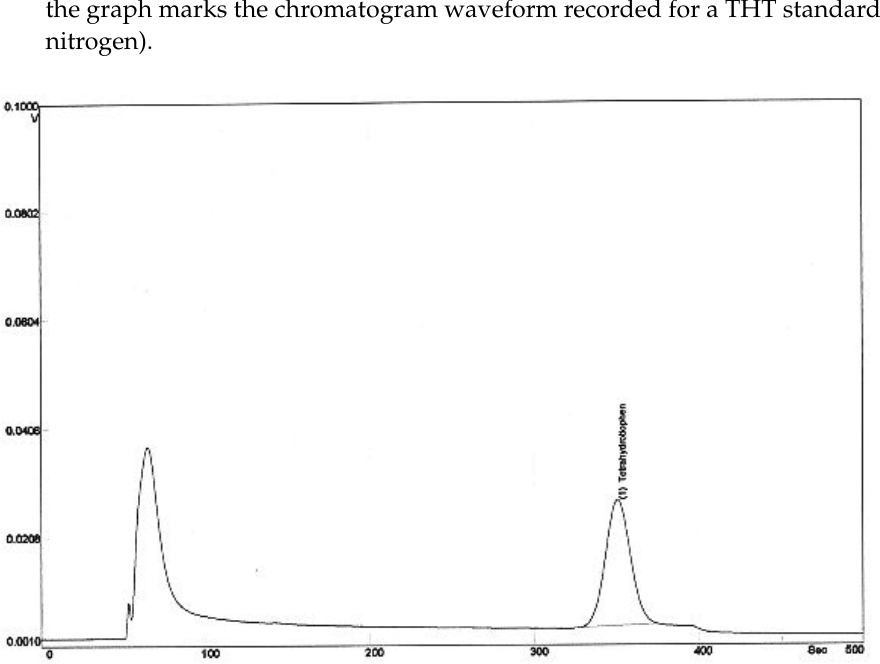
Figure 5. A sample chromatogram obtained using a Type I analyzer for M/H1 + THT, c THT = 9.40 ± 0.47 ppm. Table 5 summarizes the results regarding responses of an ED electrochemical sensor installed in a Type IV indicator analyzer (direct detection) to the presence of hydrogen in a mixture with methane. These measurements were taken for a hydrogen content in the